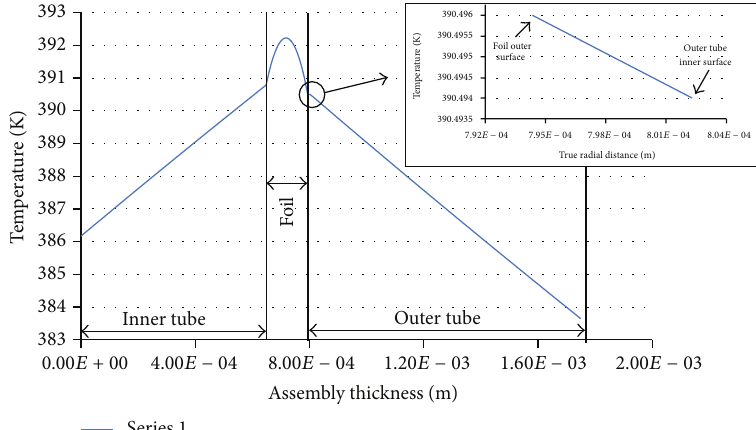
Figure 11: Radial temperature distribution across the inner and outer cladding.